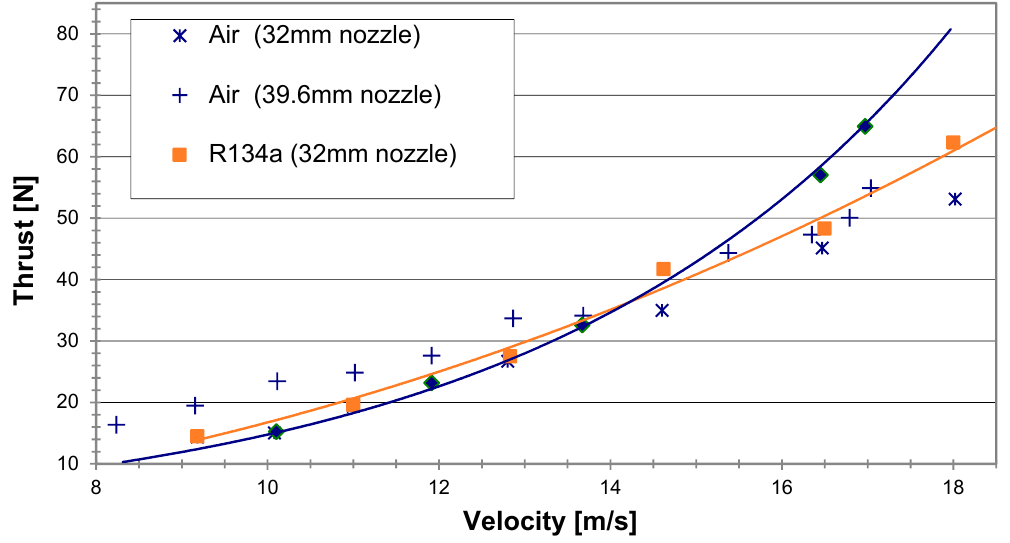
Figure 13. Test results of the thrust vs. velocity for LG R134a and air at a constant air-equivalent flow rate of 15.3 g/s for nozzle exit diameters of 32 mm and 39.6 mm.